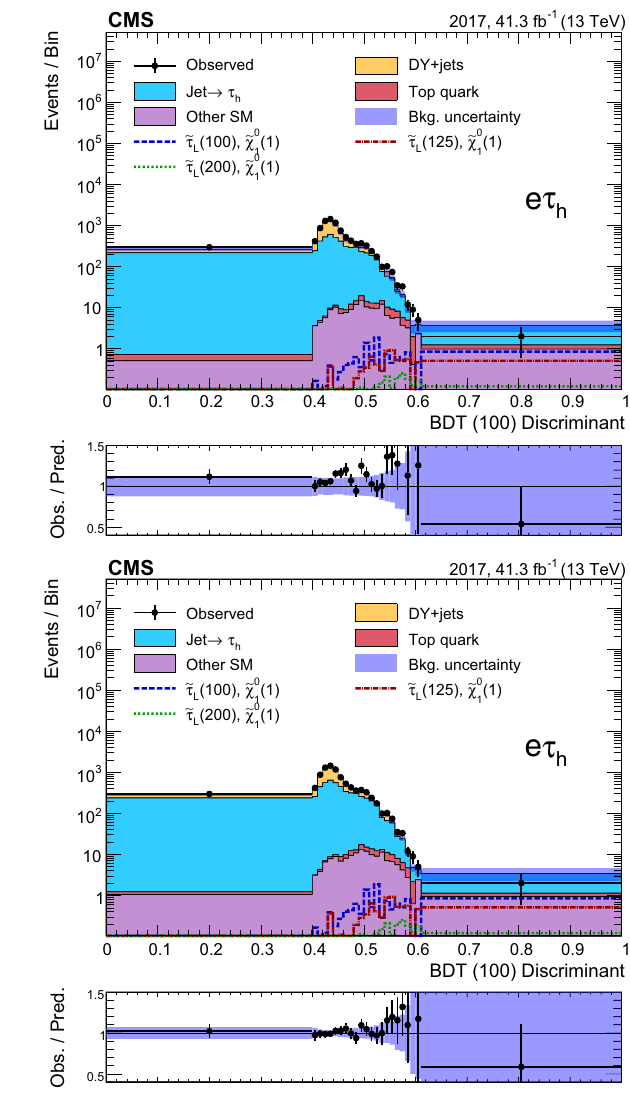
Fig. 7 Discriminant distributions for the BDT trained for a (cid:2) τ mass of 100GeV and a (cid:2) χ 0 mass of 1GeV (BDT (100)) in the e τ 1 the 2016 (left) and 2017 (right) data, before (upper) and after (lower)